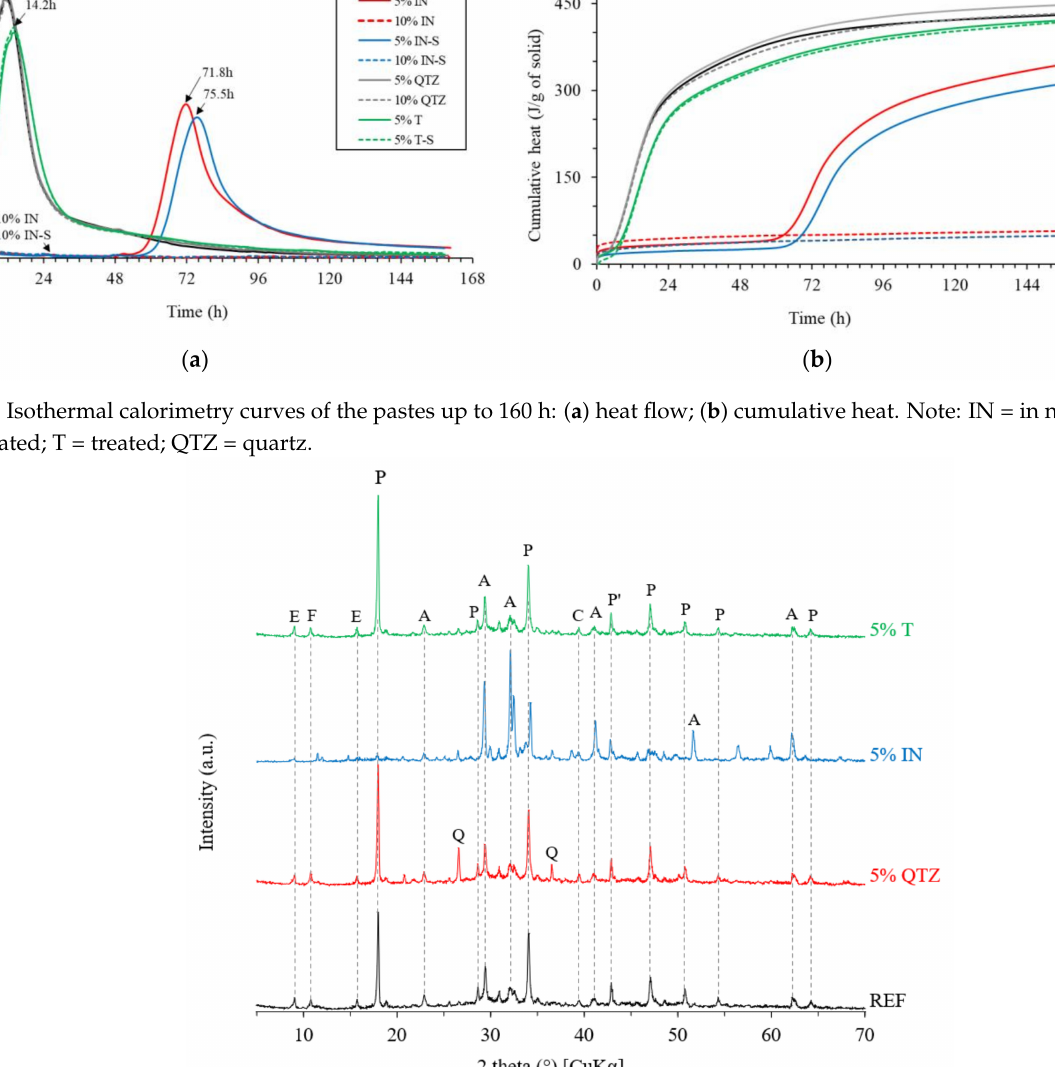
Figure 7. XRD pattern of the pastes at 160 h of hydration. A: alite; C: calcite; E: ettringite; F: ferrite; P: portlandite; P’: periclase; Q: